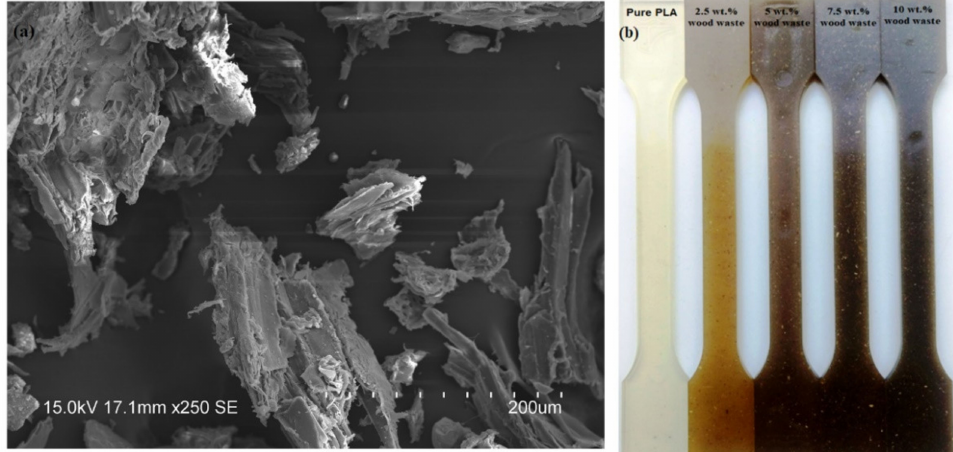
Figure 1. ( a ) SEM micrograph of North Indian rosewood waste, ( b ) fabricated